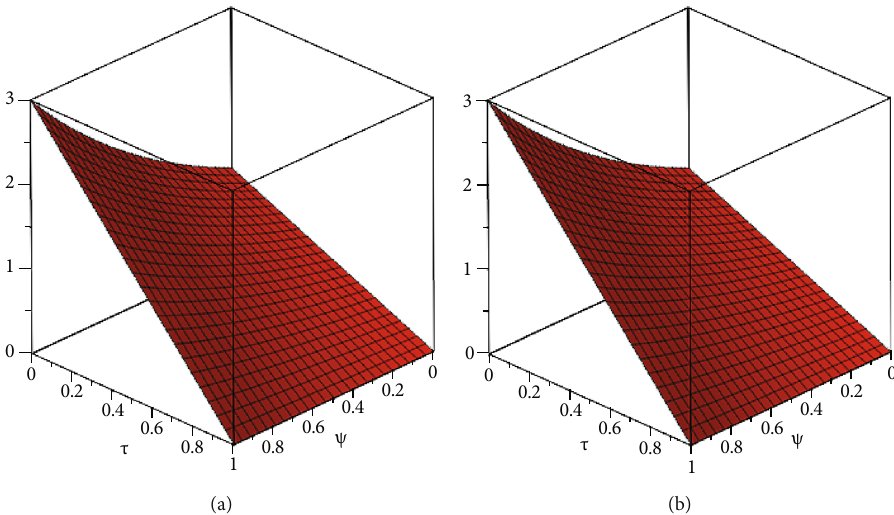
Figure 4: Example 3solu fi guretion graph. (a) Exact solution and (b) analytical solution at σ = 1 .